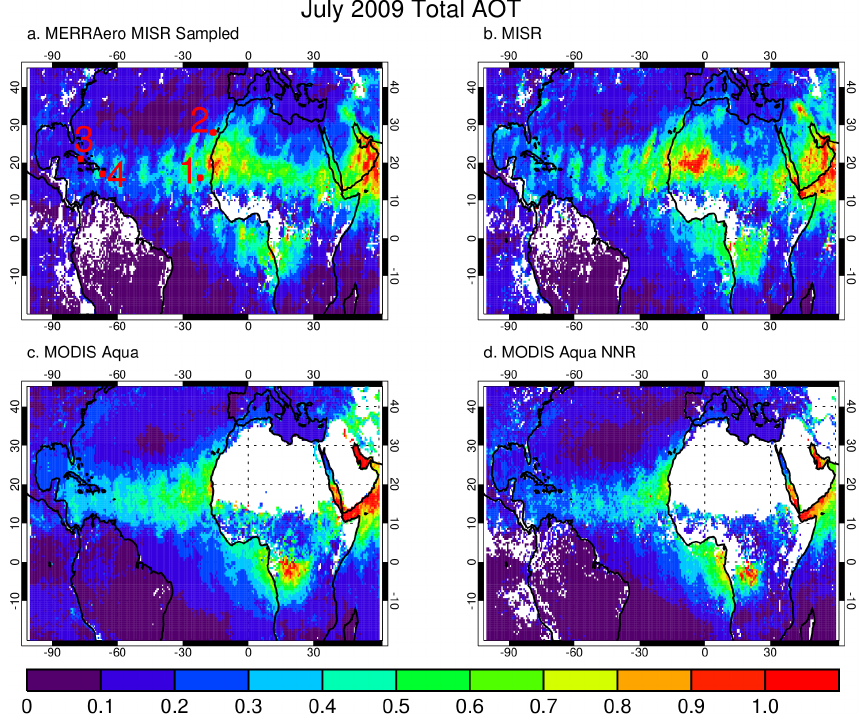
Figure 1. July 2009 AOT for MERRAero sampled along MISR track (a) , MISR (b) , MODIS Aqua standard retrieval (c) , and MODIS Aqua NNR (d) with AERONET locations overlaid (1 – Cabo Verde; 2 – Santa Cruz, Tenerife; 3 – Camaguey; and 4 – La Parguera). White areas correspond to regions where no aerosol retrievals were made.